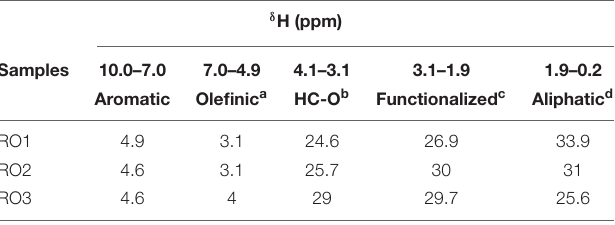
TABLE 2 | Abundance (%) of major fractions of 1 H chemical shifts assigned as previously (Hertkorn et al., 2013; Fox et al.,